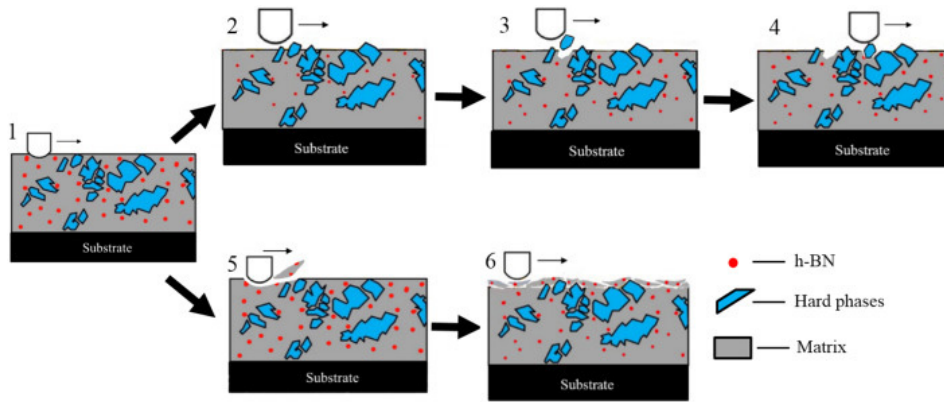
Figure 14. The wear process: adhesive wear observed at low temperature (1 – 4), abrasive wear observed at HT (1,5,6). Reproduced with permission from [107]. Copyright Elsevier, 2019. Process 1,5,6 (Figure 14, sections 1, 5, 6) represents the mechanism of adhesive wear, which occurs at high testing temperatures, and at these temperatures, the coating has low strength. The Al 2 O 3 counter body forcefully detaches the solid lubricant and matrix from the coating and leads to wear debris formation. The formed wear debris gets attached to the worn surface, and a glaze layer is formed. C1 underwent abrasive wear, and with the addition of Cu and h–BN, C2 and C3 underwent micro-plowing wear. At 400 ◦ C, a combined lubricating effect from h–BN, Cr 2 O 3, and NiO was observed on C1 and C2, and the reported wear mechanism was a mixture of adhesive and abrasive wear. However, C3 showed adhesive wear because of CuO’s lubrication and the synergistic effects of other lubricants. Delamination was observed on the worn surfaces C1, C2, and C3 at 600 ◦ C because of adhesive wear. The authors revealed that nano-Cu encapsulated with h– BN increased the h–BN content in the coating, leading to enhanced wear resistance in the temperature range of 25–600 ◦ C. Among all the coatings tested from 25 ◦ C to 500 ◦ C, C3 showed low CoF and wear properties. This was predominantly due to the higher h–BN content in the coating and the oxidation of copper to CuO.